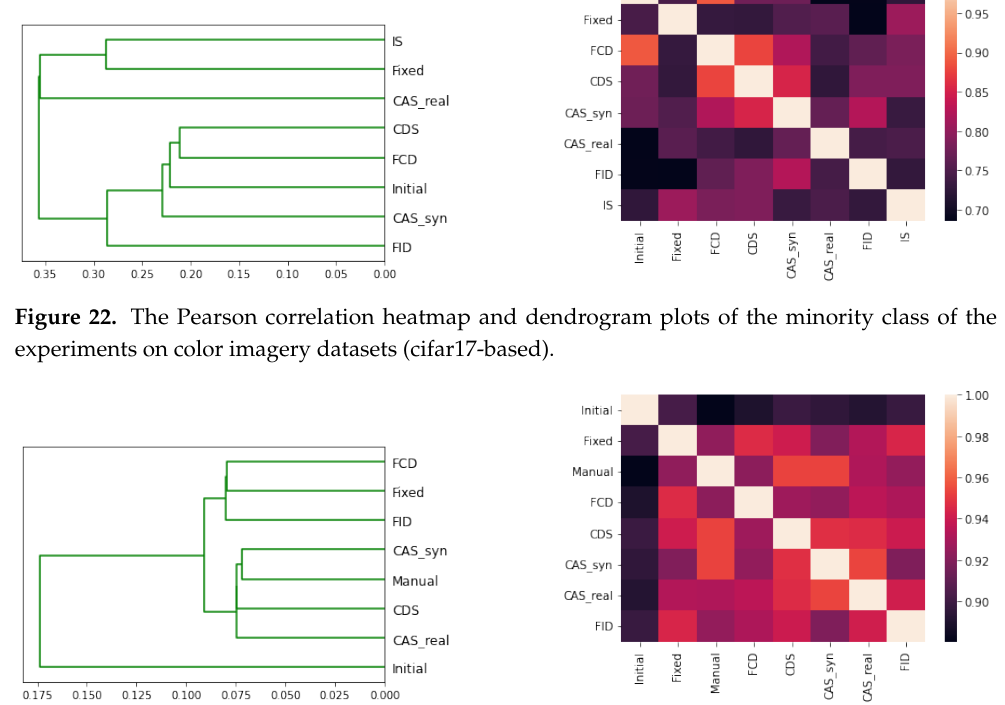
Figure 23. The Pearson correlation heatmap and dendrogram plots of the minority class of the experiments on fmnist-based